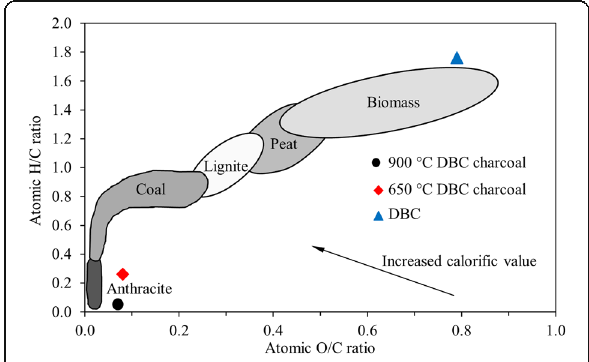
Fig. 4 The test samples plotted on a Van Krevelen plot to indicate their likeness to common solid